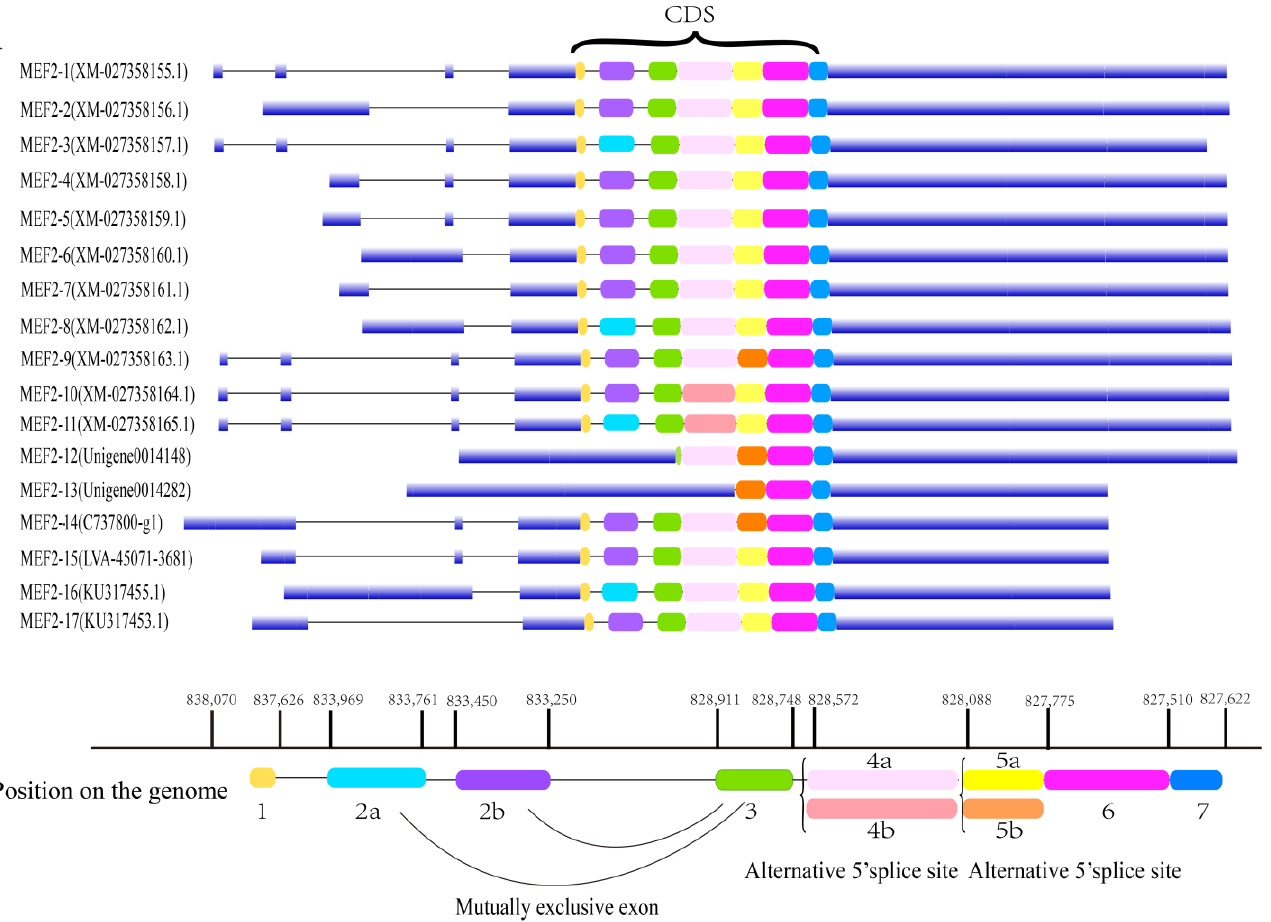
Figure 1. Alternative splicing of the MEF2 gene in L. vannamei . ( A ) The gene structures of 17 splice variants of LvMEF2 . Different colors in the CDS region represent different exons, and the blue blocks which outside the CDS region are the 5′UTR and 3′UTR of the genes, respectively. ( B ) Different CDS combinations of transcripts of LvMEF2 . Two forms of alternative splice variants, a mutually exclusive exon and an alternative 5′ splice site, exist in the CDS region of LvMEF2. Mutually exclusive exons are two exons that cannot be present in one transcript at the same time, as 2a and 2b. Alternative 5’splice site is the splice site at the 5’end of one exon was different, resulting in an extension of the 5’end of the exon in one of the transcripts, as 4a and 4b, and 5a and 5b. There are two forms in exon 4 in which 4a is missing 18 bp base at the 5 (cid:48) end of exon 4 compared with 4b. There are two forms in exon 5 in which 5a is missing 3 bp bases at the 5 (cid:48) end of exon 5 compared with 5b. The numbers 1, 3, 6, and 7 indicate exons 1, 3, 6, and 7 of LvMEF2 , respectively. The 17 transcripts were translated into amino acids to obtain their protein